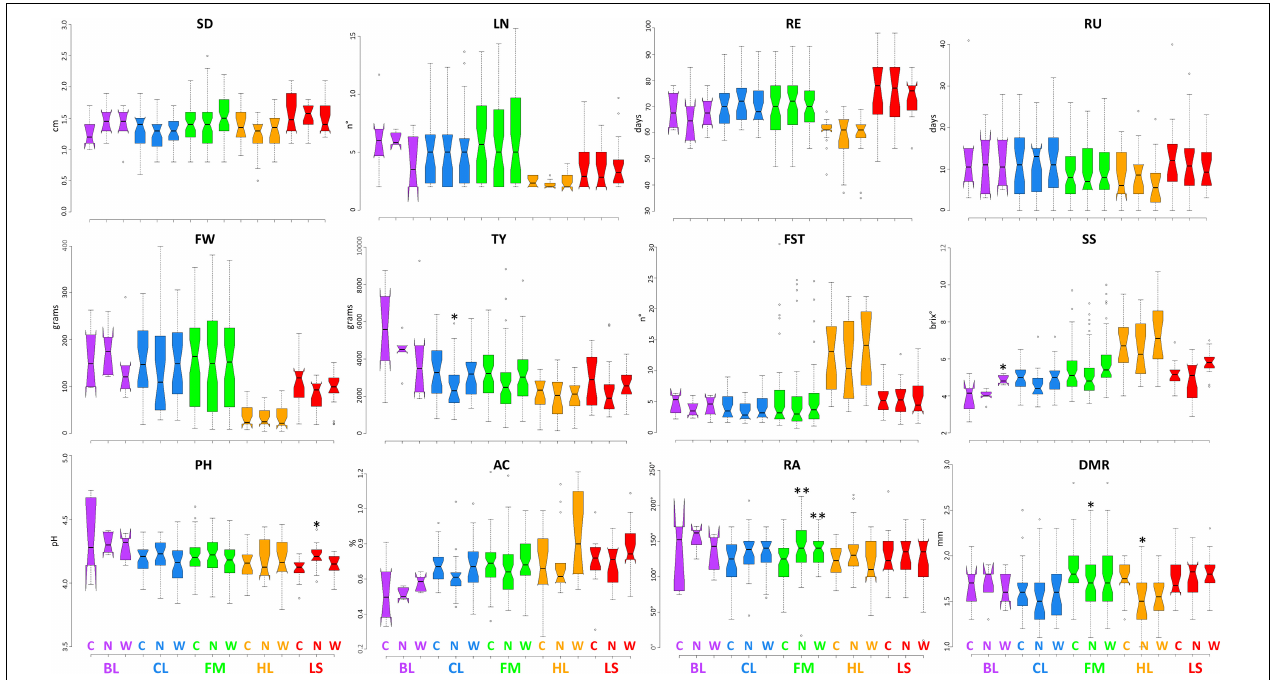
FIGURE 2 | Variation for quantitative traits in the five cultivar groups grown under control and stress conditions in Italy. Notched boxplots showing median values and quartiles for the five considered cultivar groups grown in Italy under control (C), water deficit (W), and nitrogen stress (N). The measurement scale for each trait is reported on the Y-axis; details in Table 2 . The asterisks indicate significant differences with respect to the control condition according to the Dunnett’s test; the single ( ∗ ) and the double ( ∗∗ ) asterisk indicates p < 0.05 and p < 0.01, respectively. BL = breeding lines, CL = elite cultivars, FM = landraces for the fresh market, HL = heirlooms, LS = long shelf-life